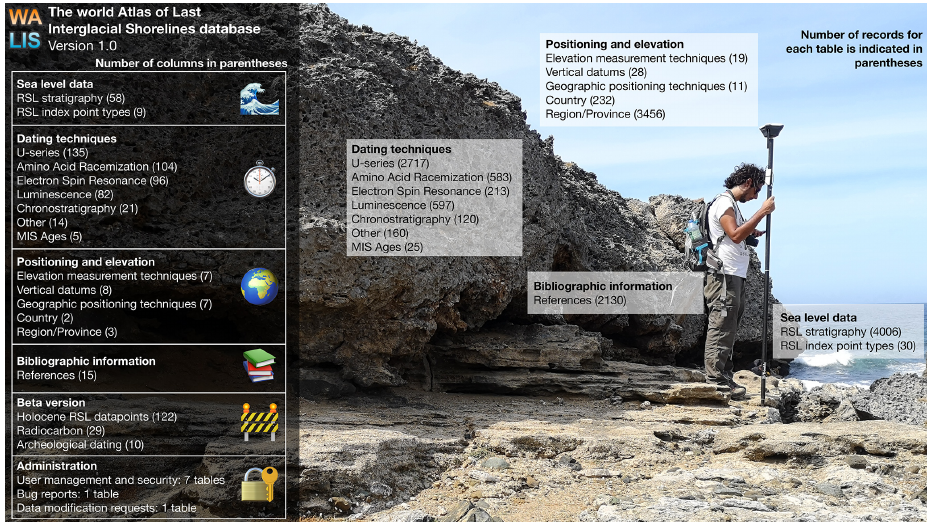
Figure 2. Summary of the number of columns in each table and the number of records (rows) per table in WALIS 1.0. Photo by Alessio Ro- vere (2019). Location: Boca Cortalein, Curaçao. In the picture: geologist Ciro Cerrone measuring the elevation of a Pleistocene beach deposit using real-time kinematic